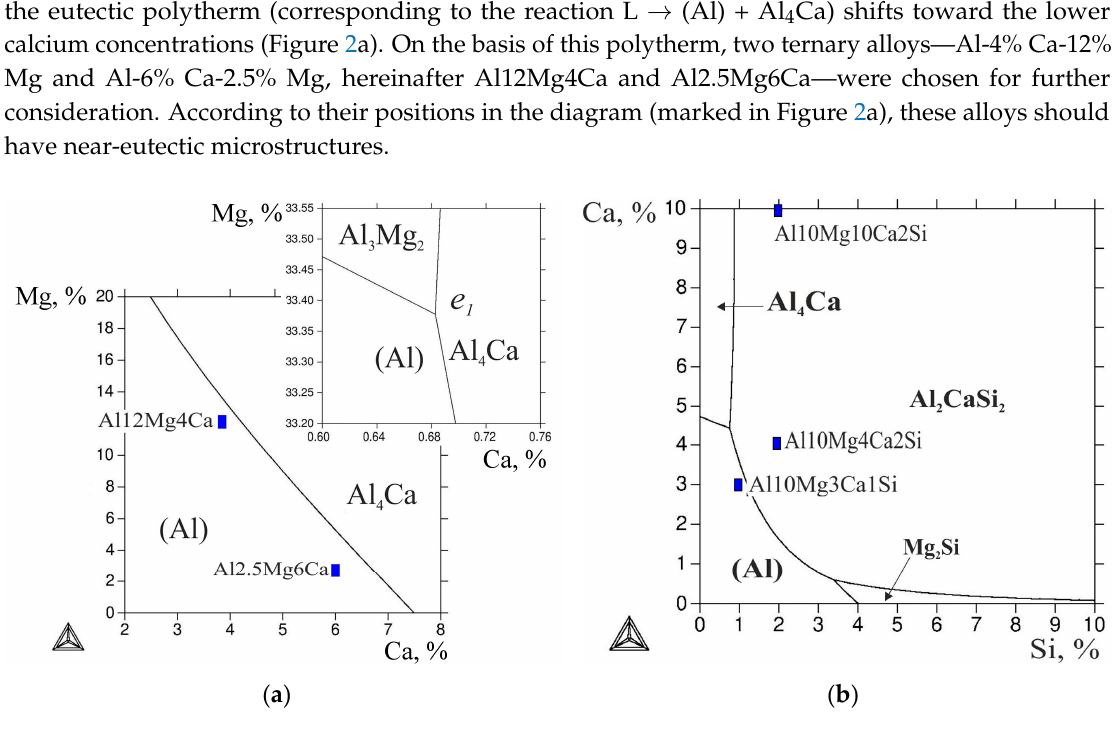
Figure 2. The calculated liquidus projection of systems Al-Ca-Mg ( a ) and Al-Ca-Mg-Si ( b ) at 10 wt % Mg.